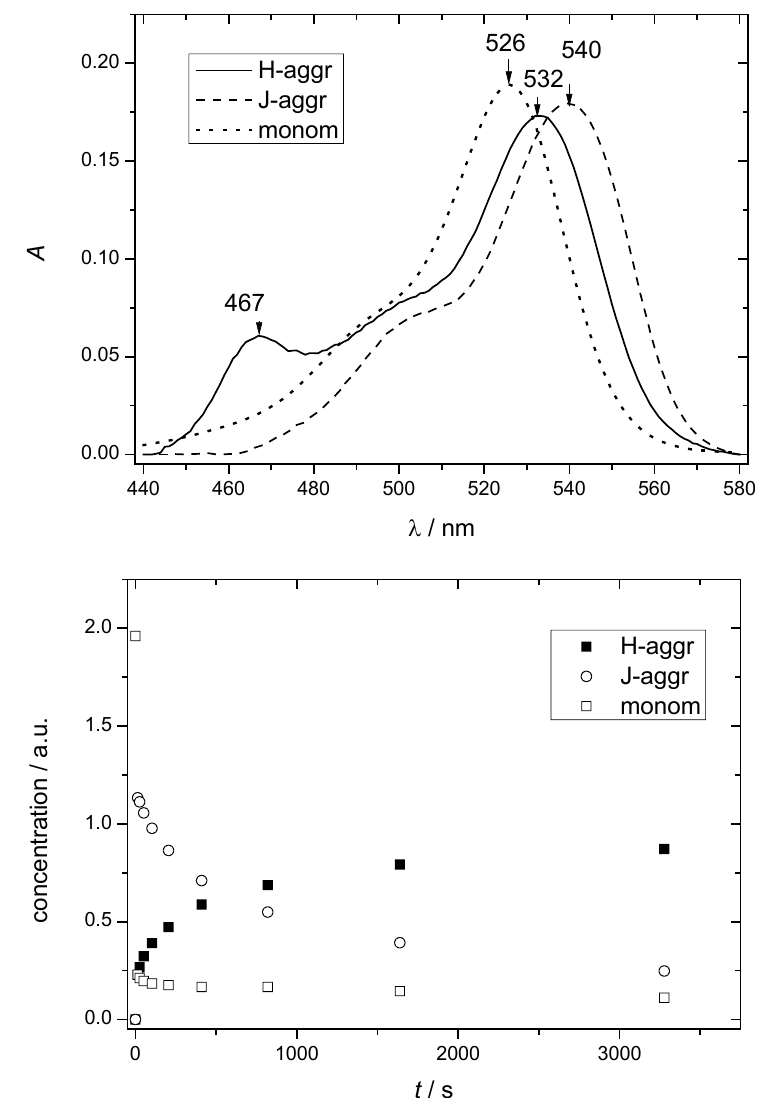
Figure 5. Spectra (upper) and concentrations (lower) of the components determined by multivariate curve resolution. Calculated from the data obtained by the experiment at 20°C and pure rhodamine 6G